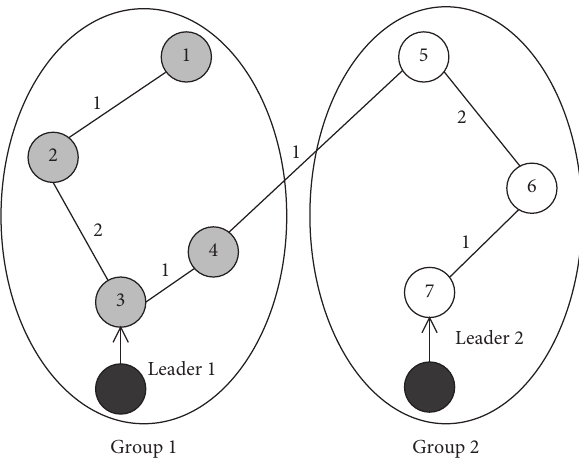
Algorithm 1 (algorithm for designing leaders). For the given